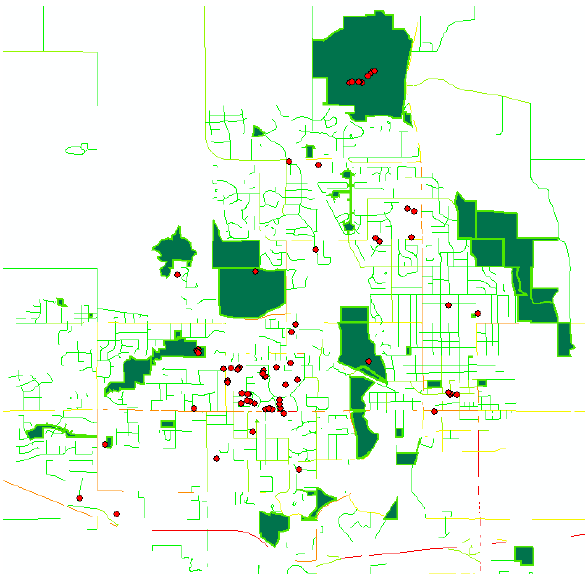
Figure 5. Power places in Ames in relation to green